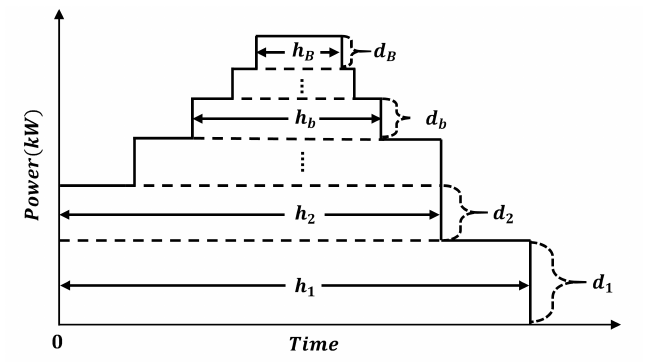
Figure 3. Schematic diagram of block division in block bidding